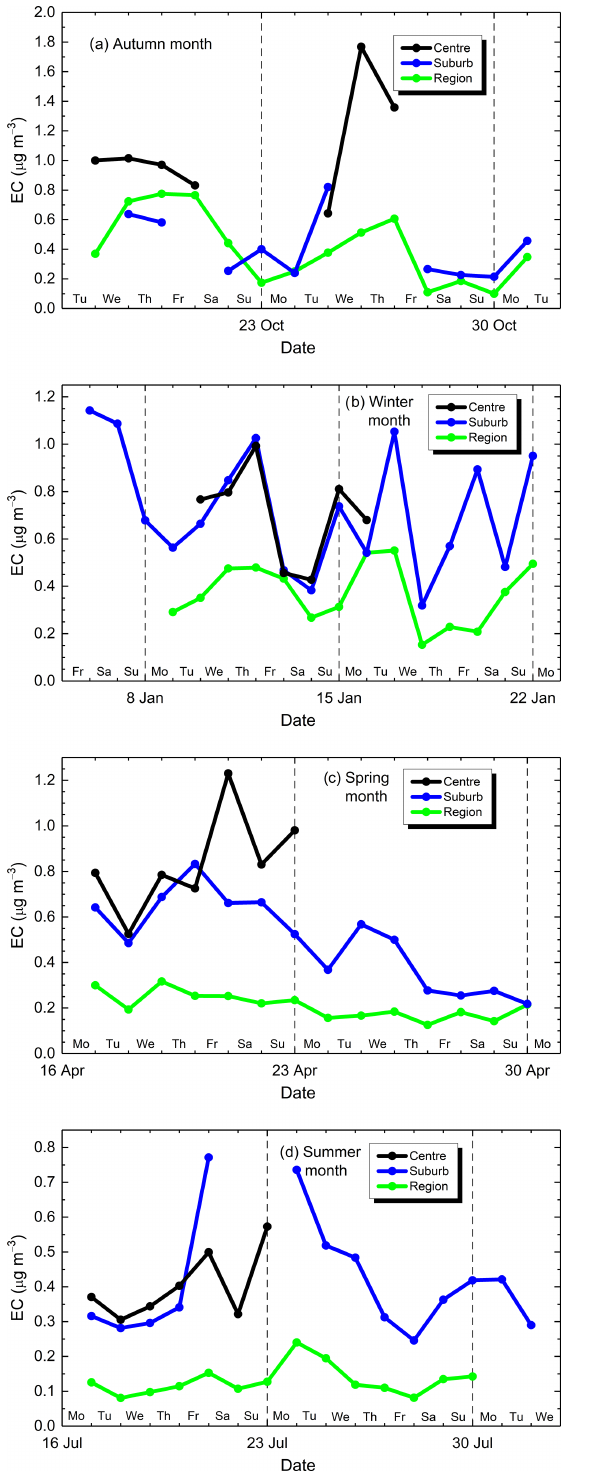
Figure 4. Time variation of WSOC for regional background in the Carpathian Basin, suburban area and city centre of Budapest during the aerosol sampling time intervals for different months (a–d)